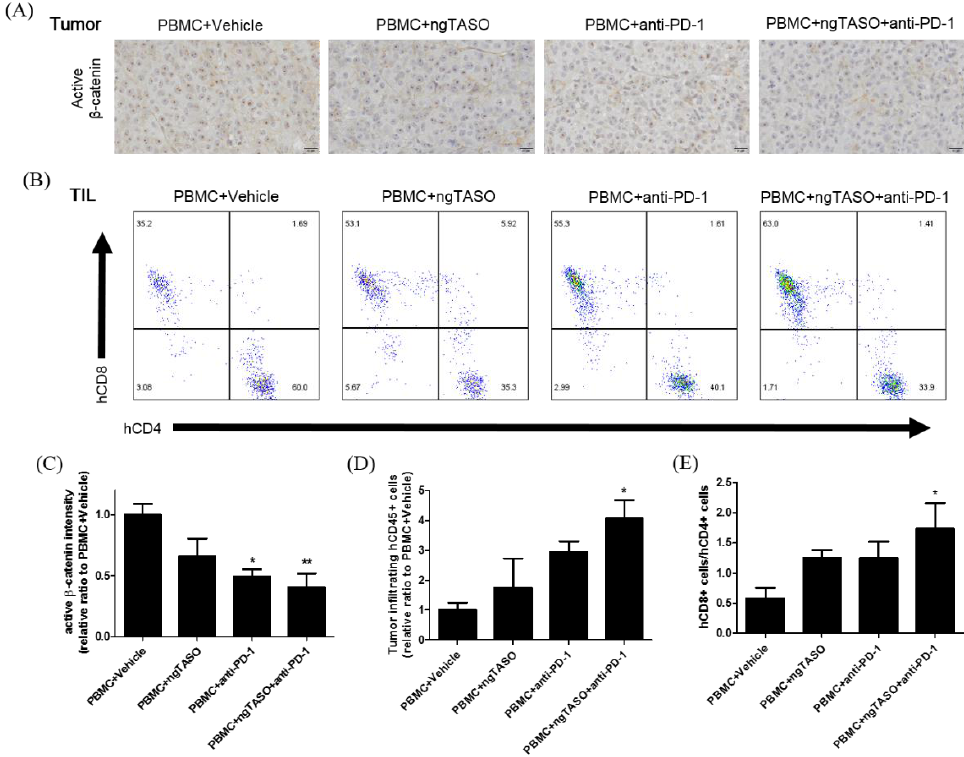
Figure 4. Effects of TGF- β 2 blockades combined with PD-1 inhibition on activation of β -catenin and infiltration of CD8+ cytotoxic T lymphocytes (CTLs). Active β -catenin expression level in the xenografted tumor was measured by IHC, and the subpopulation of tumor infiltrated human T cells was assessed by FACS analysis. ( A ) Representative IHC images against active β -catenin, and ( B ) representative flow cytometry plot of hCD4+ and hCD8+ cells in an hCD3+-gated population. ( C ) The relative DAB intensity ratio of active β -catenin was evaluated in at least four fields per specimen and five to six specimens per group. The relative ratio of ( D ) tumor-infiltrating hCD45+ cells and ( E ) the ratio of hCD8+ cells to hCD4+ cells among tumor infiltrated hCD3+ cells were presented. FACS data were obtained from five to six mice per group. The results are expressed as mean ± S.E.M. * p < 0.05 and ** p < 0.01 vs. PBMC+Vehicle group (Dunnet’s test). Bar = 20 µ m. h,